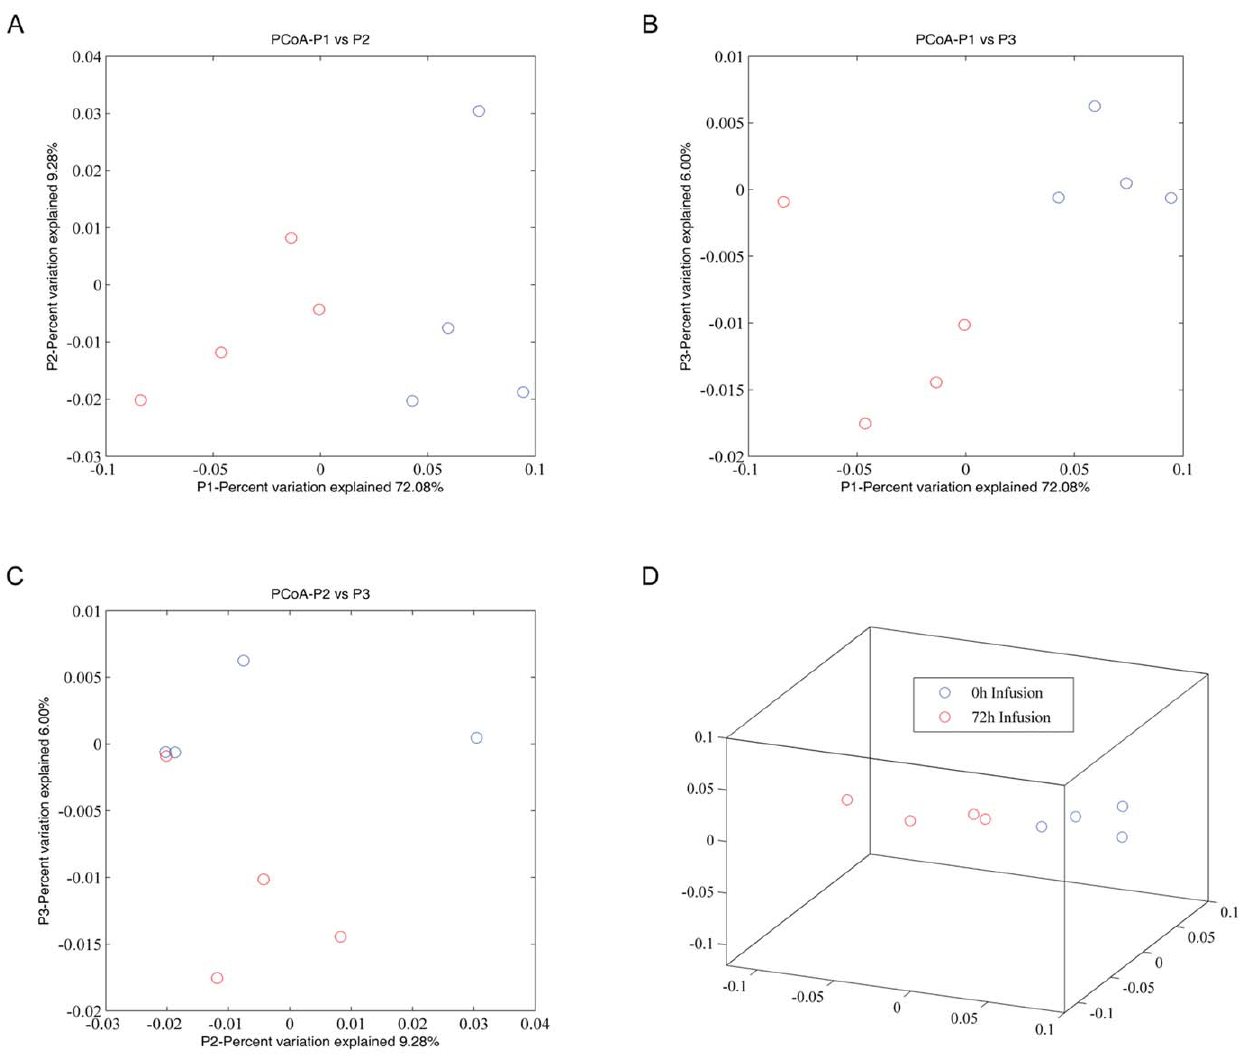
Figure 6. Principal Coordinates Analysis of weighted UniFrac values between pre-infusion (0 h; blue) and 72 h infusion (red) ( N =4). (A) Visualization of the first two dimensions (un-scaled); (B) Visualization of the first and third dimensions (un-scaled); (C) Visualization of the second and third dimensions (un-scaled); (D) in 3-D.